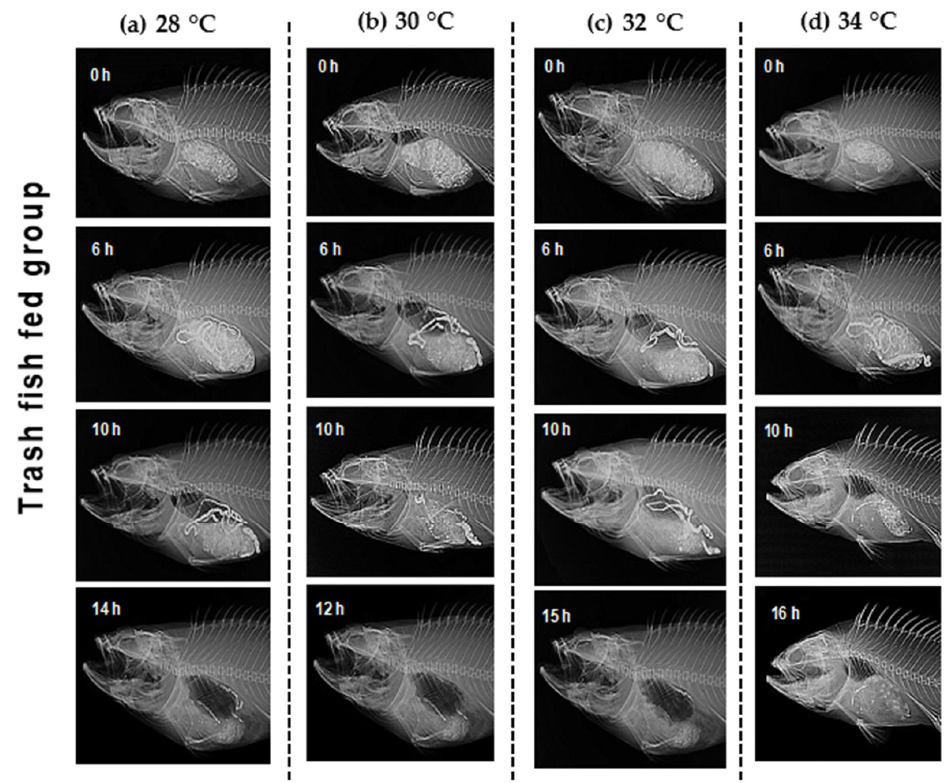
Figure 6. Movement of radio ‐ opaque barium sulphate (BaSO 4 ) along the alimentary tract of adult hybrid Sabah grouper. Each panel shows the passage of ingested BaSO 4 ‐ treated trash fish food through the alimentary tract of the hybrid Sabah group at ( a ) 28 °C, ( b ) 30 °C, ( c ) 32 °C, and ( d ) 34 °C. Five fish were used for each sampling point and temperature. Only images with remarkable movement are shown.